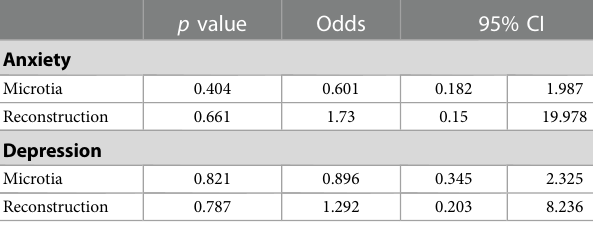
TABLE 4 Logistic regression analysis of microtia and affective